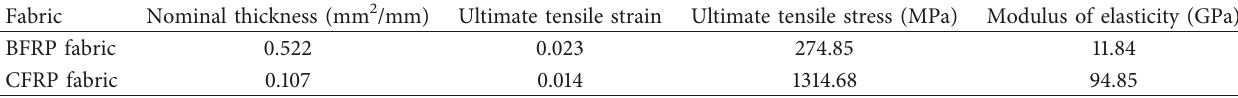
Table 3: Material properties of FRP fabric.